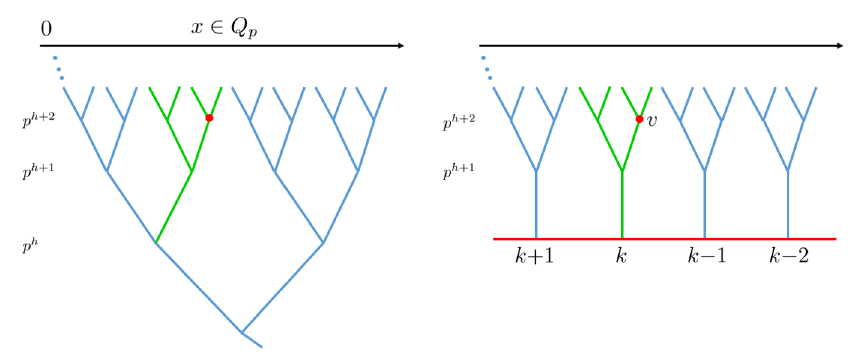
Figure 5. The coordinates on the cylinder type BH. Each branch of the BH is taken from the BT tree emanating from the vertex labeled ( p h , 0) in Poincare coordinates, which is colored green in the figure. The coordinates of v is ( k, p h +2 , y ( h +2) )